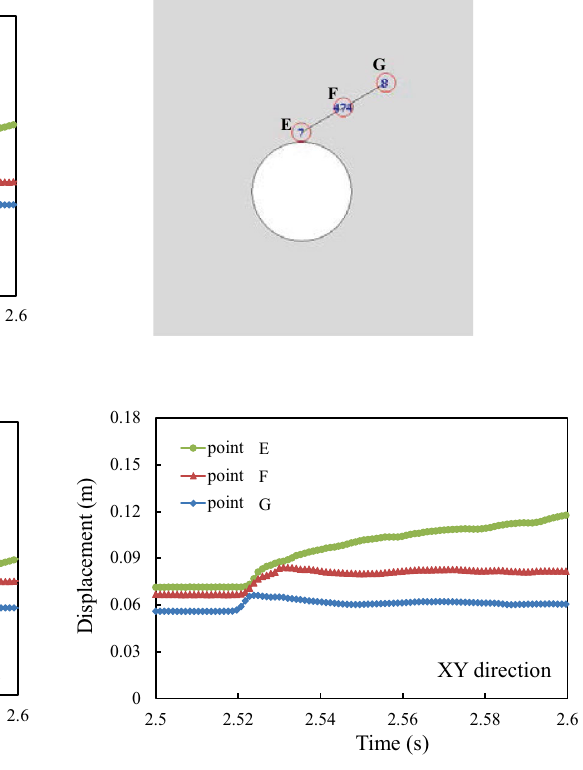
Fig. 21 Displacement velocity–time evolution curves for three moni- toring points in structural plane when subjected to external dynamic disturbances. Note: y direction indicates the vertical direction, x